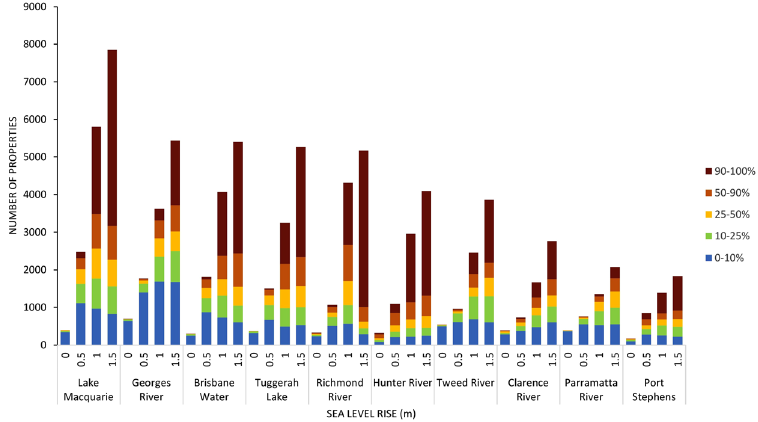
Figure 6. Total numbers of properties exposed to inundation (HHWSS) for the 10 most exposed estuaries under 0 m, 0.5 m, 1.0 m and 1.5 m sea level rise scenarios including the proportion of property land